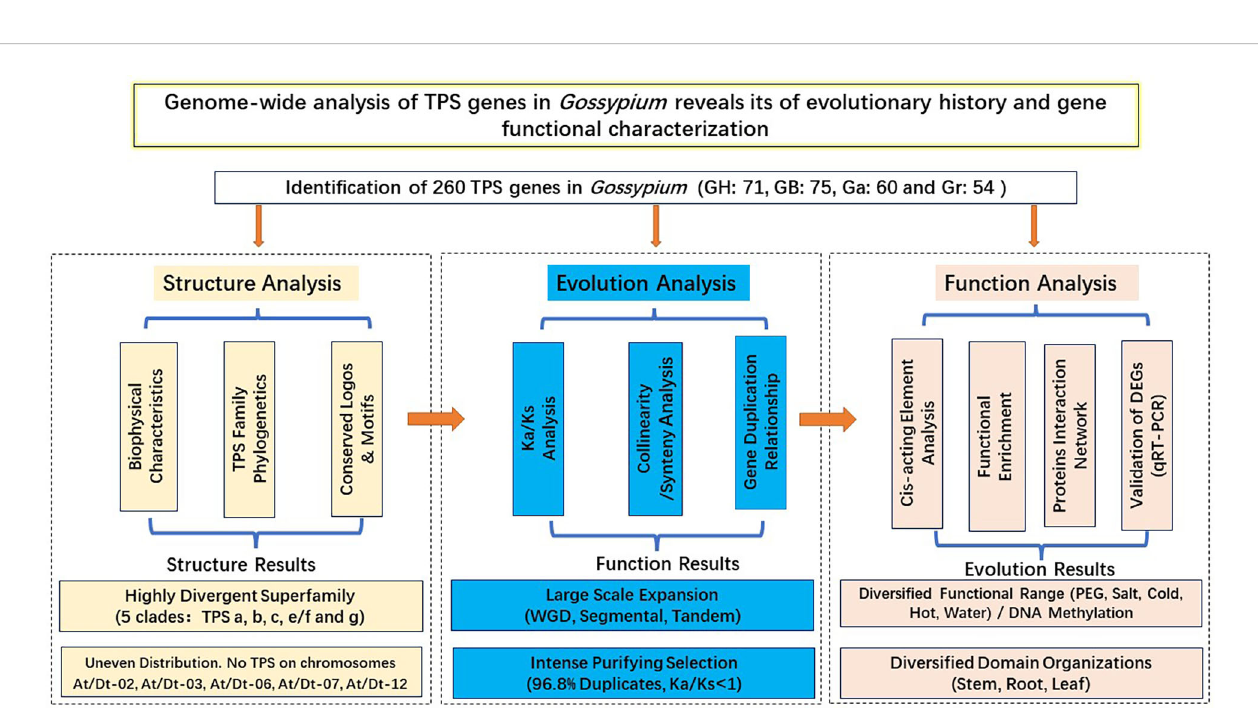
FIGURE 12 Genome-wide and systematic analysis of the TPS gene family in Gossypium.